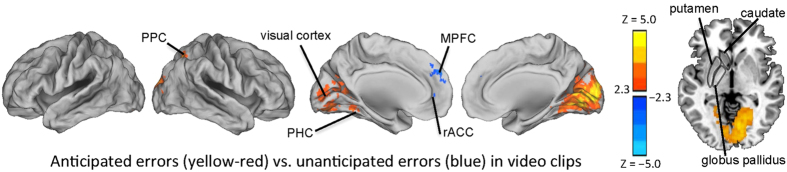
Brain regions showing significantly stronger activity during anticipated errors than surprising errors are shown with yellow-red color and brain areas showing stronger activity during surprising than anticipated errors are shown with blue color.Anticipated errors specifically activated PPC, visual cortex, and PHC. Surprising errors specifically activated MPFC and rACC. All statistical parameteric maps were thresholded Z > 2.3 and cluster-wise corrected at P < 0.05.